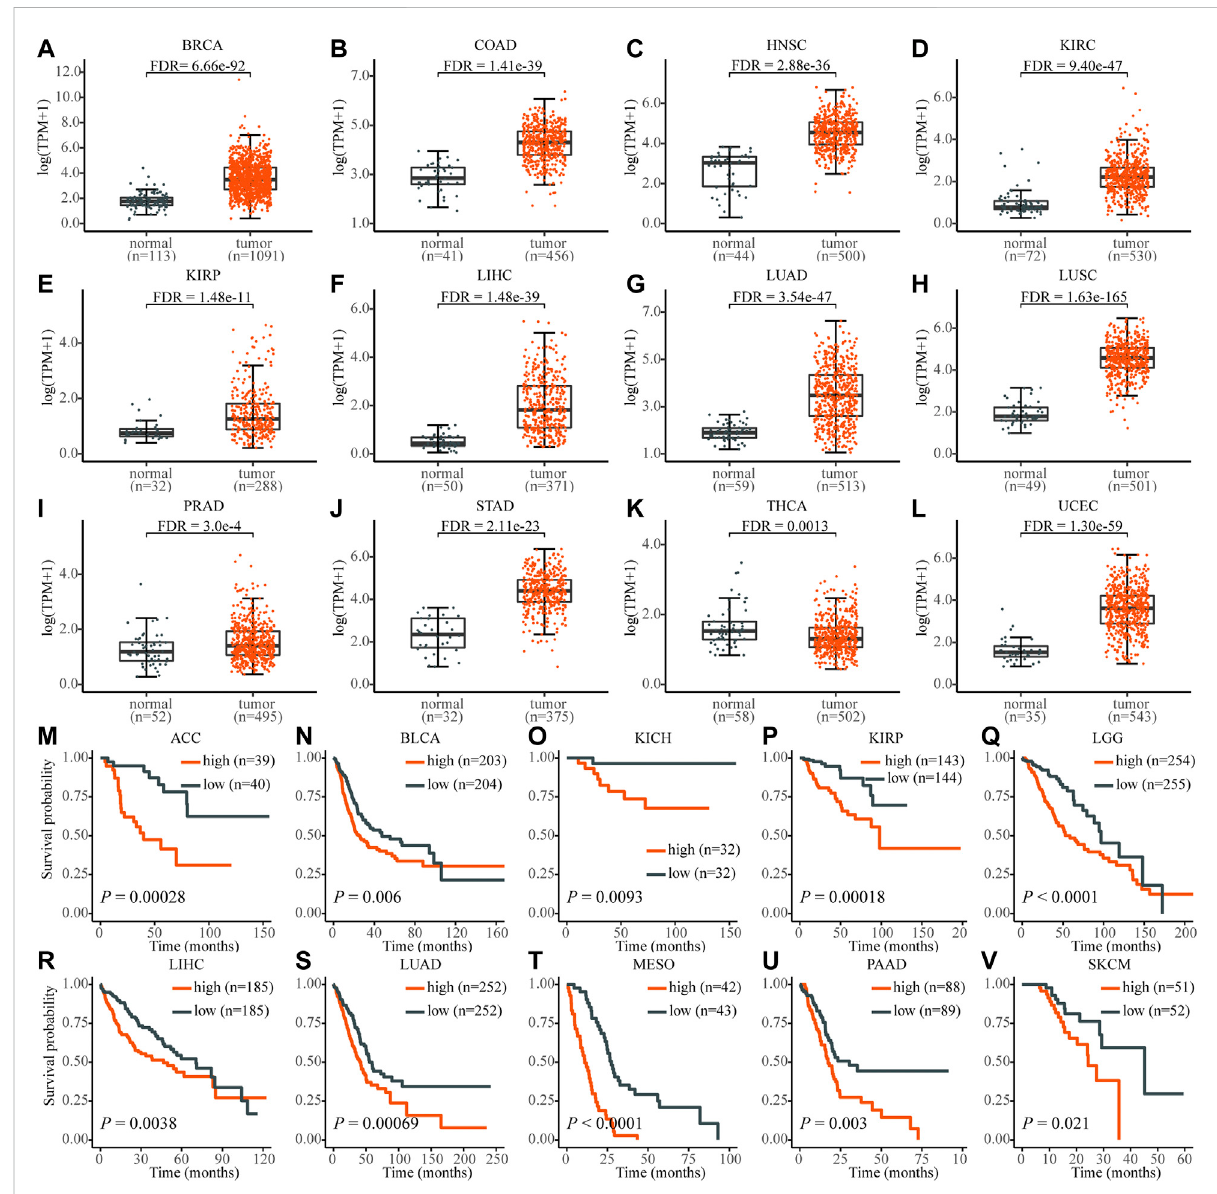
FIGURE 1 Theexpressionlevel ofPRR11 ofnormal tissues(black) andtumortissues(red)inpan-canceranditshighexpressionaresigni fi cantly associated with poor prognosis. (A) BRCA, breast invasive carcinoma; (B) COAD, colon adenocarcinoma; (C) HNSC, head and neck squamous cell carcinoma; (D) KIRC, kidney renal clear cell carcinoma; (E) KIRP, kidney renal papillary cell carcinoma; (F) LIHC, liver hepatocellular carcinoma; (G) LUAD, lung adenocarcinoma; (H) LUSC, lung squamous cell carcinoma; (I) PRAD, prostate adenocarcinoma; (J) STAD, stomach adenocarcinoma; (K) THCA, thyroid carcinoma; (L) UCEC, uterine corpus endometrial carcinoma; (M) ACC, adrenocortical carcinoma; (N) BLCA, bladder urothelial carcinoma; (O) KICH, kidney chromophobe; (P) KIRP; (Q) LGG, brain lower grade glioma; (R) LIHC; (S) LUAD; (T) MESO, mesothelioma; (U) PAAD, pancreatic adenocarcinoma; (V) SKCM, skin cutaneous